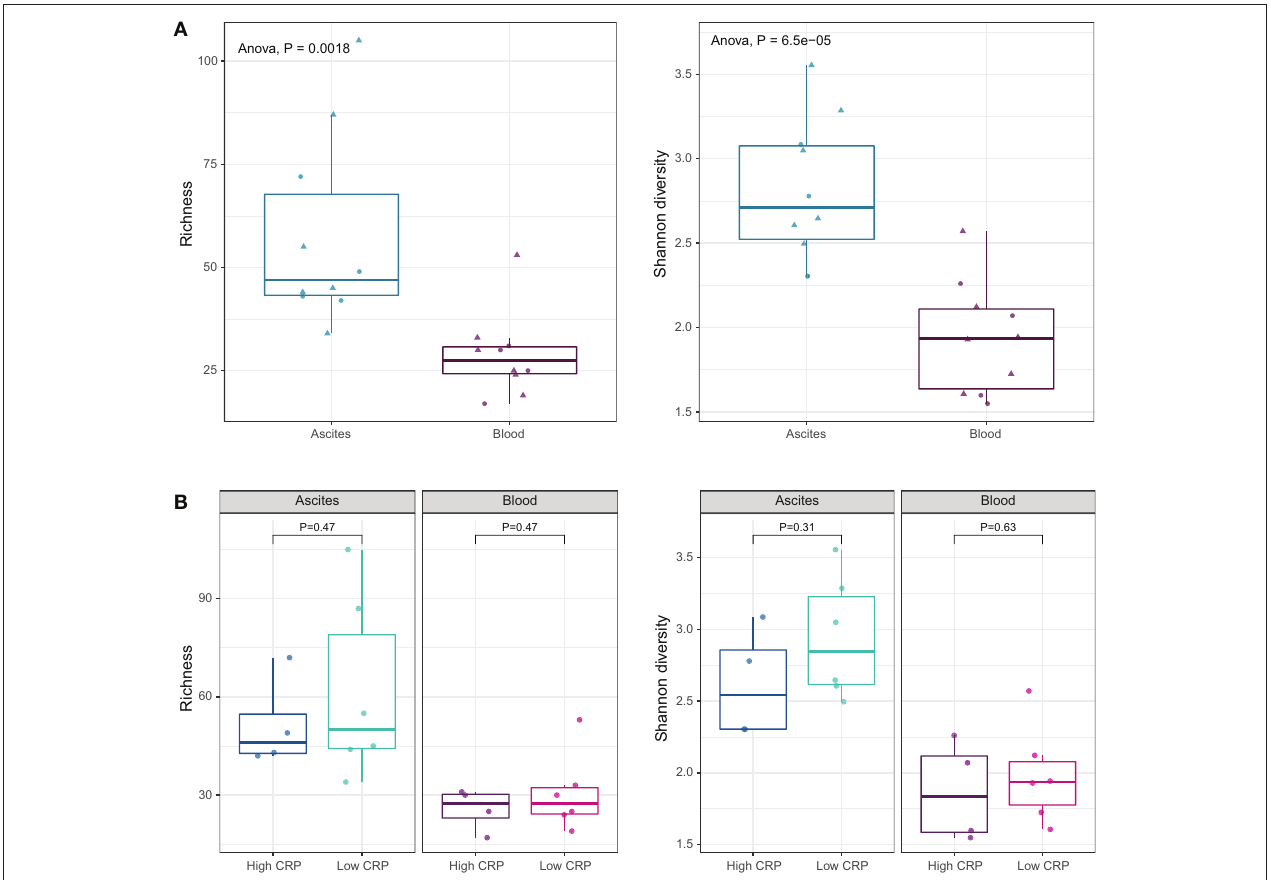
FIGURE 3 | (A) Alpha diversity indices at genus level. Ascites microbiota has higher richness and diversity compared to peripheral blood microbiome. (B) Alpha diversity indices under different systemic inflammation status. The inflammation status does not affect the microbial diversity of the ascites or blood samples.